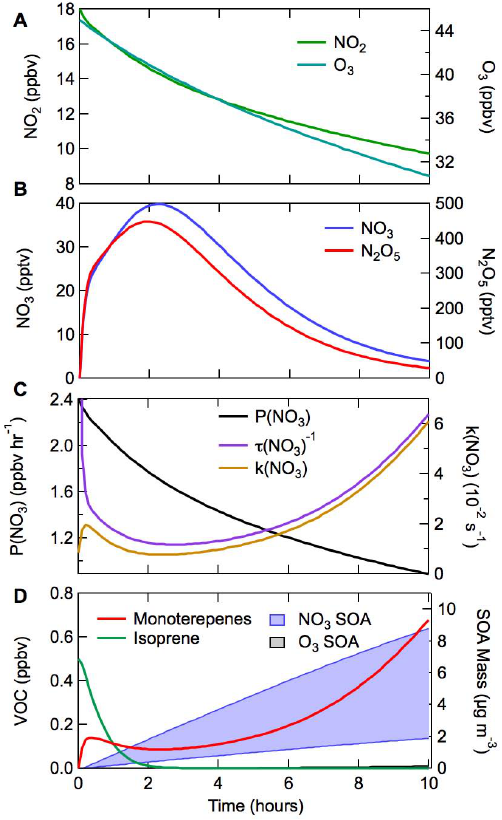
Fig. 17. Model simulation of a large NO 3 source and a large bio- genic VOC emission source, intended to represent an urban air mass transported to a forested region. (A) NO 2 , O 3 ; (B) NO 3 , N 2 O 5 ; (C) nitrate radical production rate, P (NO 3 ) (left axis), and inverse steady-state lifetime, τ (NO 3 ) − 1 , and first-order loss rate coefficient to biogenic VOCs, k (NO 3 ) , plotted together on the right axis. (D) Summed monoterpenes ( α - and β -pinene) and isoprene (left axis), and SOA mass from NO 3 and O 3 oxidation of these VOCs (right axis). The blue shaded range indicates high and low SOA yields (see text) for monoterpene oxidation. Note that SOA from O 3 ox- idation is small and barely visible on the scale of SOA from NO 3 oxidation in this simulation.